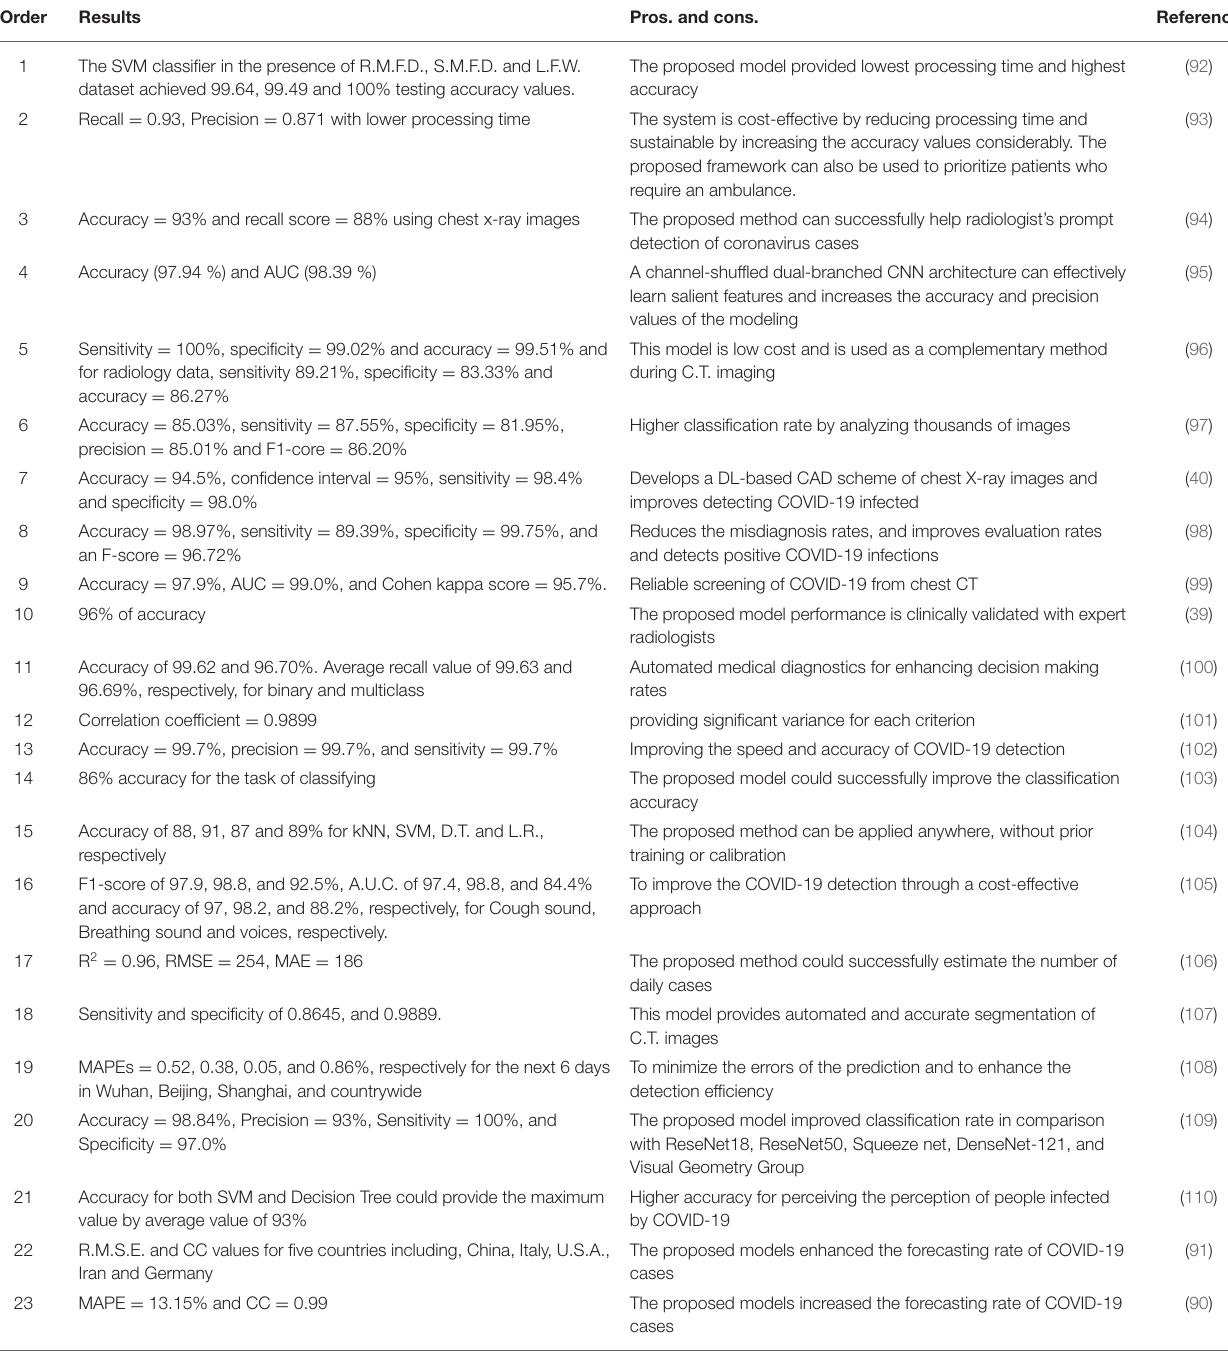
TABLE 9 | The main findings of the study for the application of ML-based techniques. Order Results Pros. and